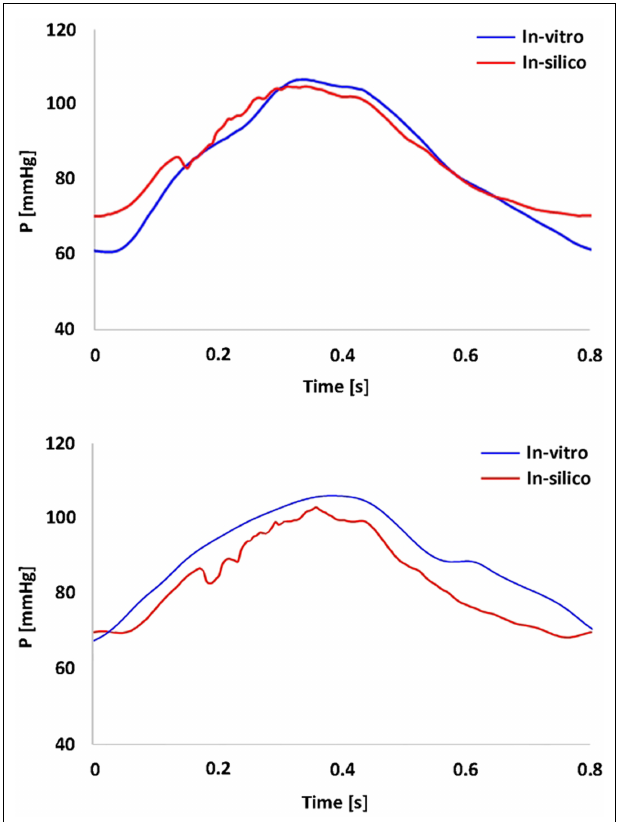
FIGURE 3 | Summary of pressure data showing the realistic shape and range of the pressure waveform gathered in the TGA model ( top panel ) and in the control model ( bottom panel ) . In vitro ( blue ) and in silico ( red ) signals are superimposed.